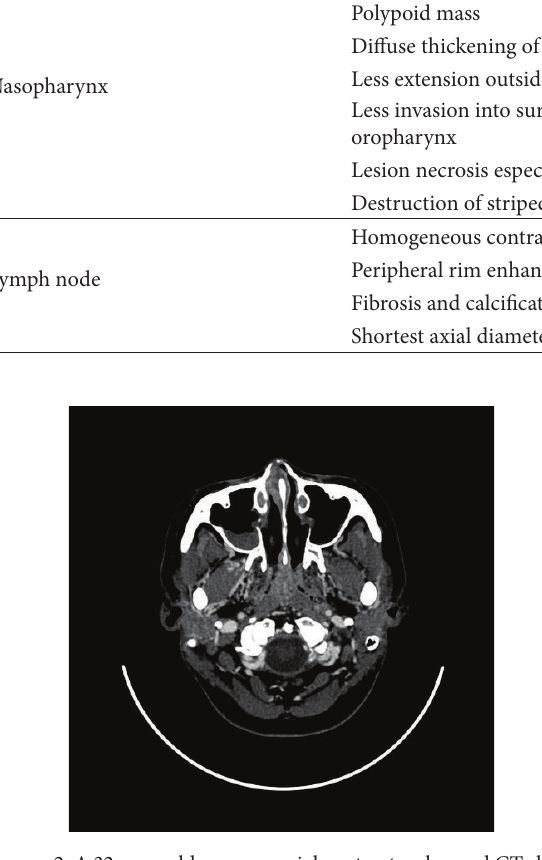
Figure 3: A 32-year-old woman, sagittal contrast-enhanced CT shows small central necrosis area in the nasopharyngeal